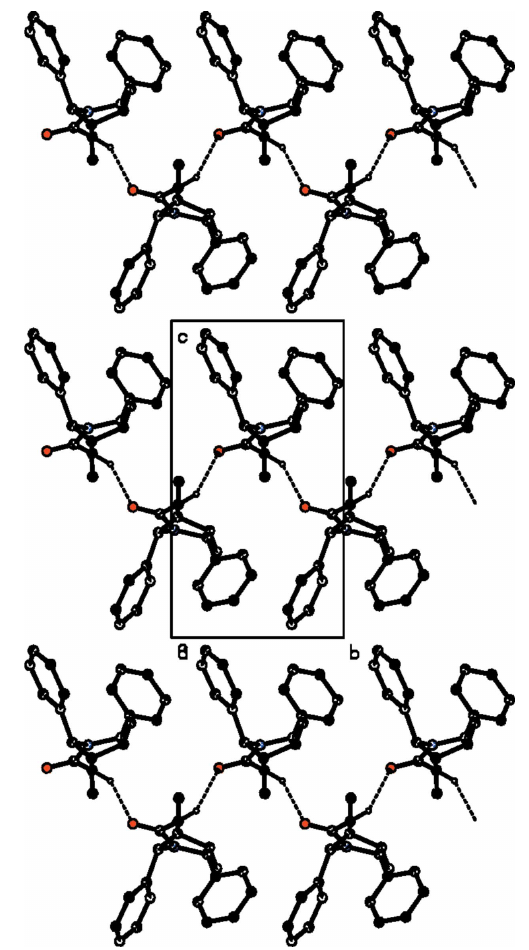
Figure 3 The overall crystal packing of the title compound, viewed along the b axis. Hydrogen bonds are shown as dashed lines, and only the H atoms involved in hydrogen bonding have been